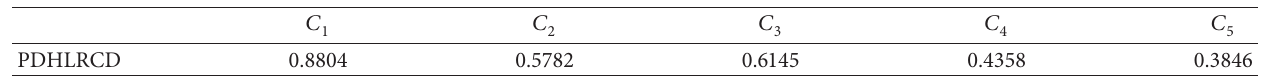
Table 12: PDHLRCD.